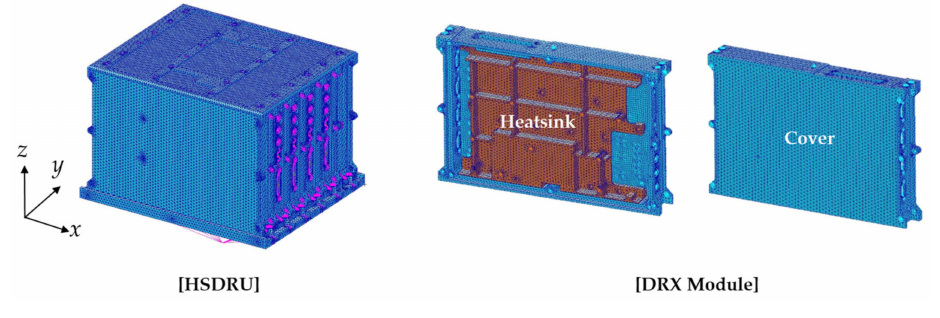
Figure 8. FEM of HSDRU.